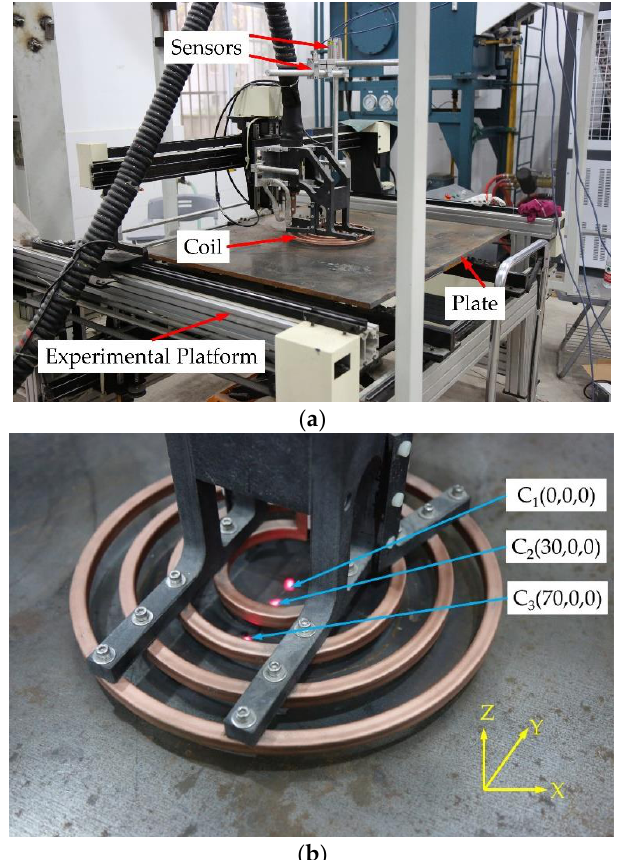
Figure 3. Schematic diagram of the induction heating experiment: ( a ) Experimental platform for induction heating and ( b ) Positions of the temperature measurement points.